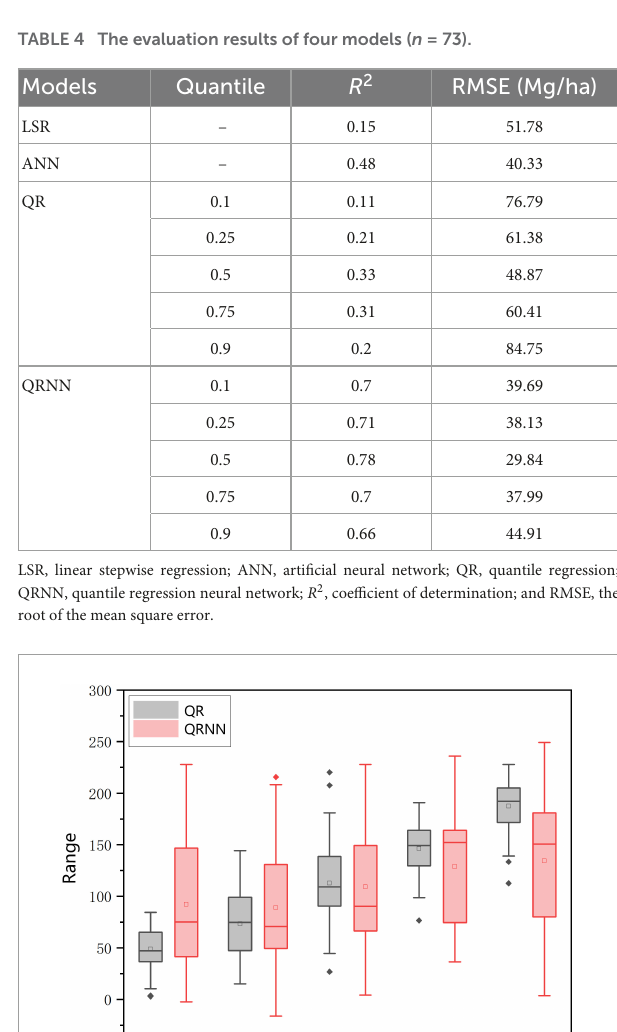
QRNN, the values are greater than 0.4; even the R 2 of the 0.5